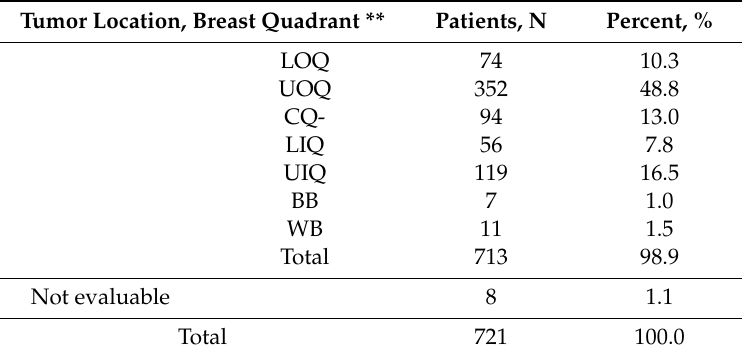
Table 8. Tumor location in the breast.